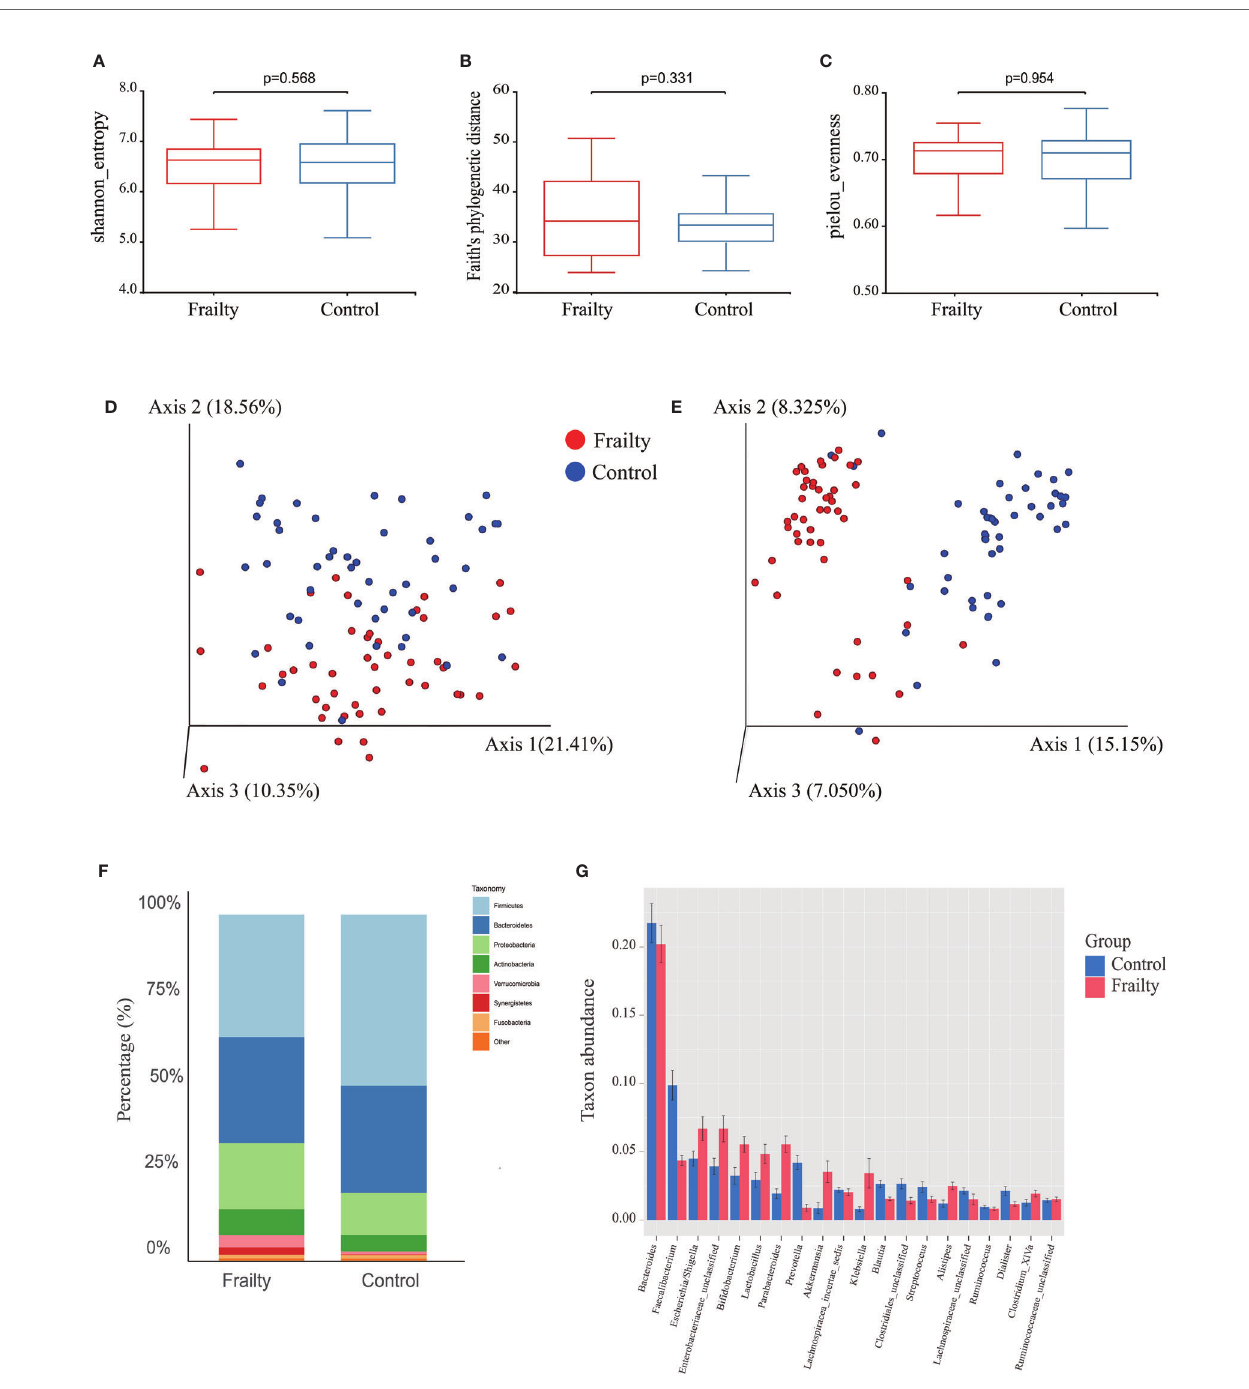
FIGURE 2 | Fecal microbiota alpha and beta diversity indices in older adults with frailty and healthy controls. The box plots depict differences in microbiome diversity indices between frail and control groups using the (A) Shannon diversity index, (B) Faith ’ s phylogenetic distance index, and (C) Pielou ’ s evenness index. Each box plot represents the median, interquartile range, and minimum and maximum values. The level of similarity between the microbial communities detected in frail (red) and control (blue) groups was assessed via principal coordinate analysis (PCoA) based on (D) weighted UniFrac and (E) Bray – Curtis distances. These analyses revealed the (F) top 8 most abundant phyla and the (G) top 20 most abundant genera between the frail and control